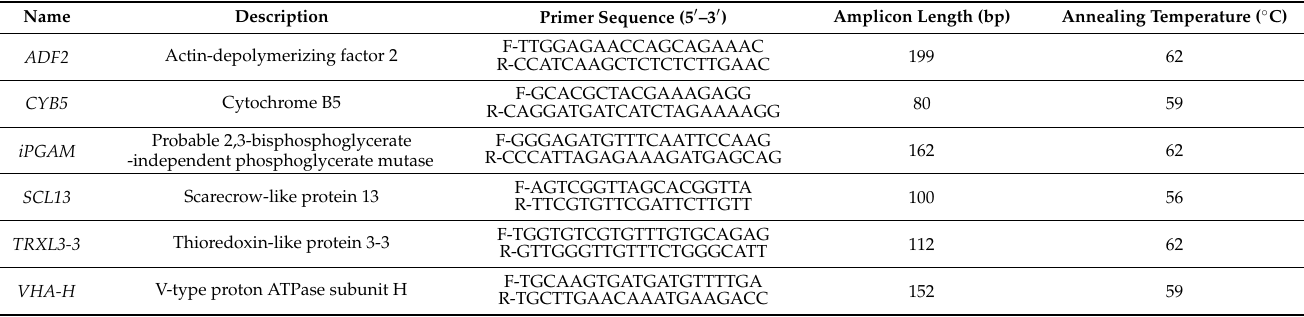
Table 1. Description, primer sequences, amplicon length, and qPCR annealing temperature of six candidate reference genes (RGs).